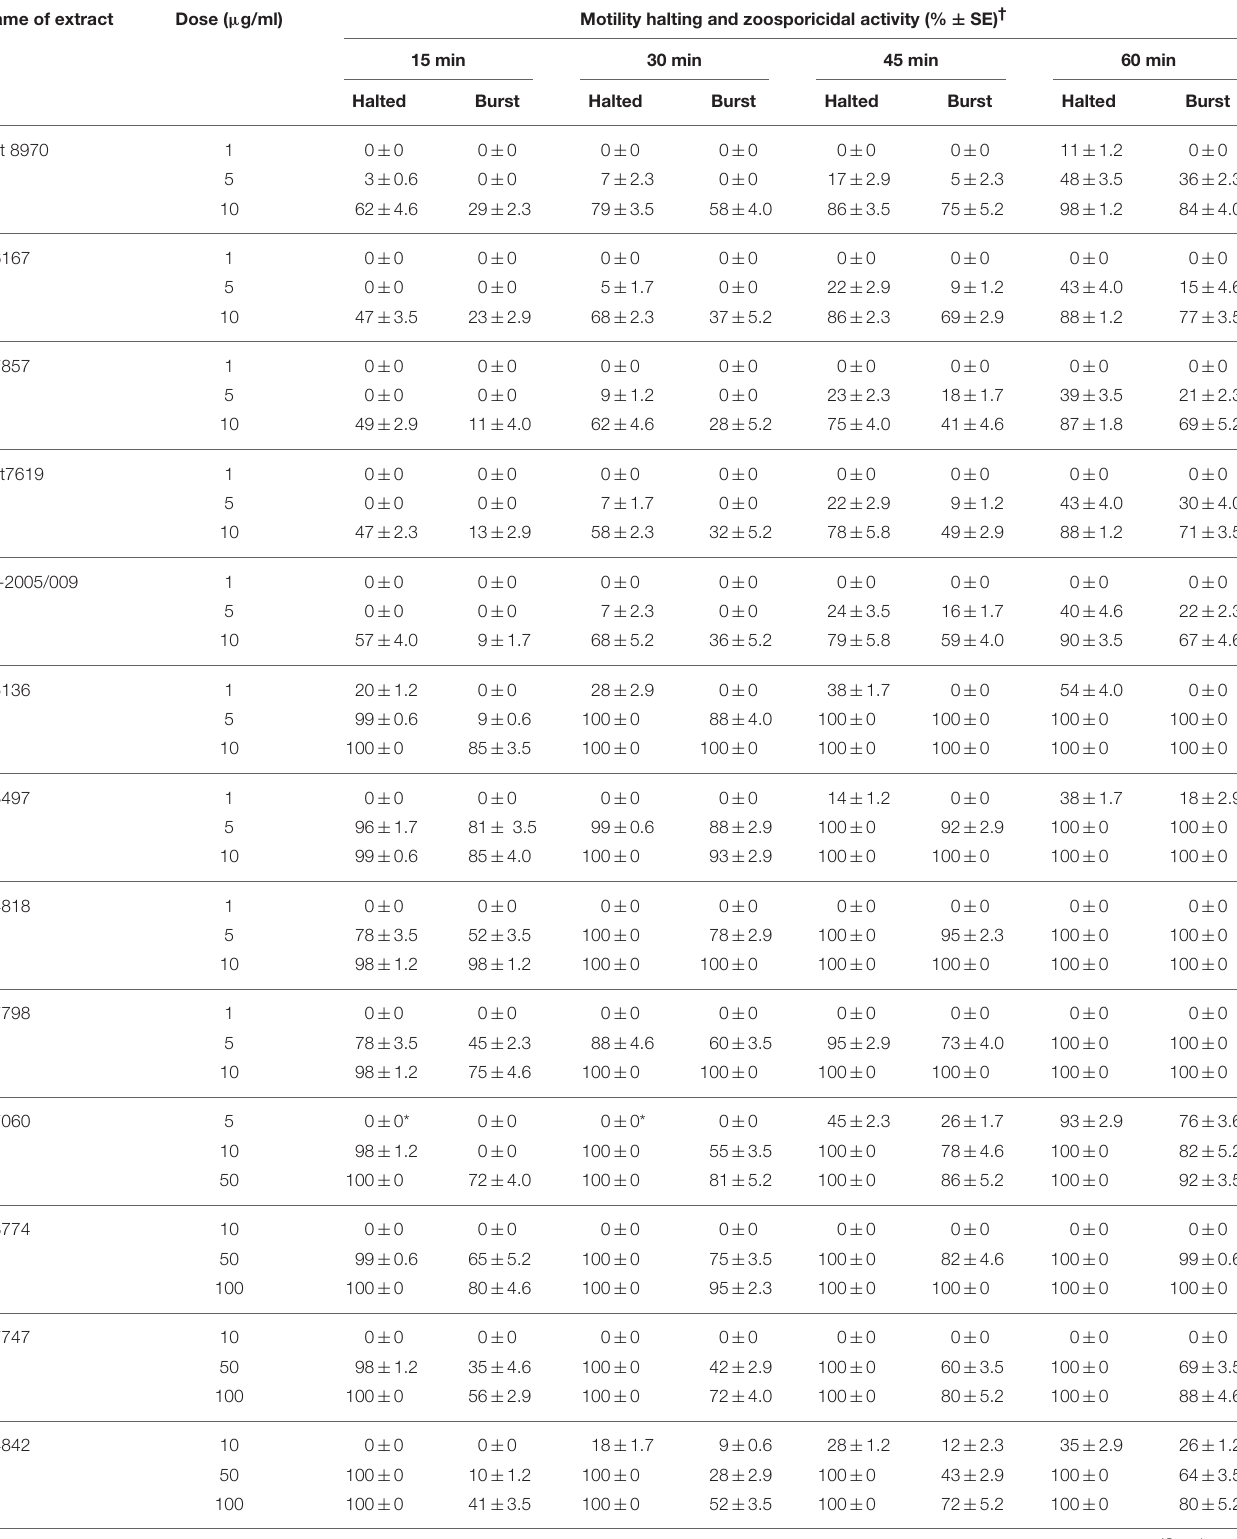
TABLE 1 | Motility halting and zoosporicidal activity of marine Streptomyces spp. extracts against the downy mildew pathogen Plasmopara viticola . Name of